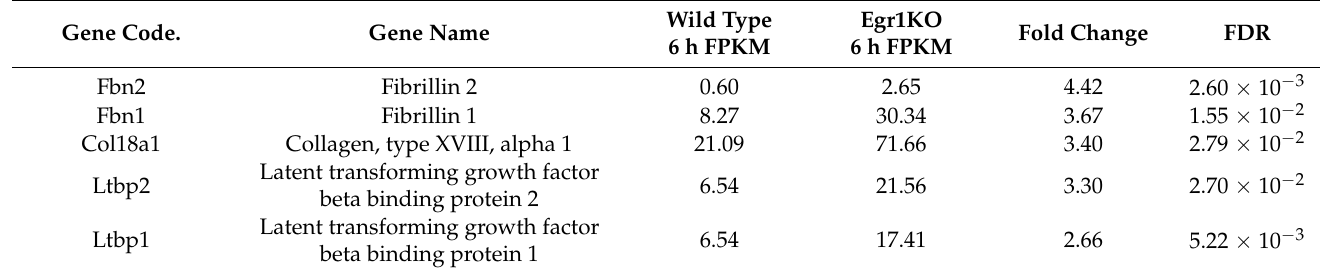
Table 6. Egr1KO LECs express elevated levels of genes that encode zonule associated proteins at 6 h PCS. Gene